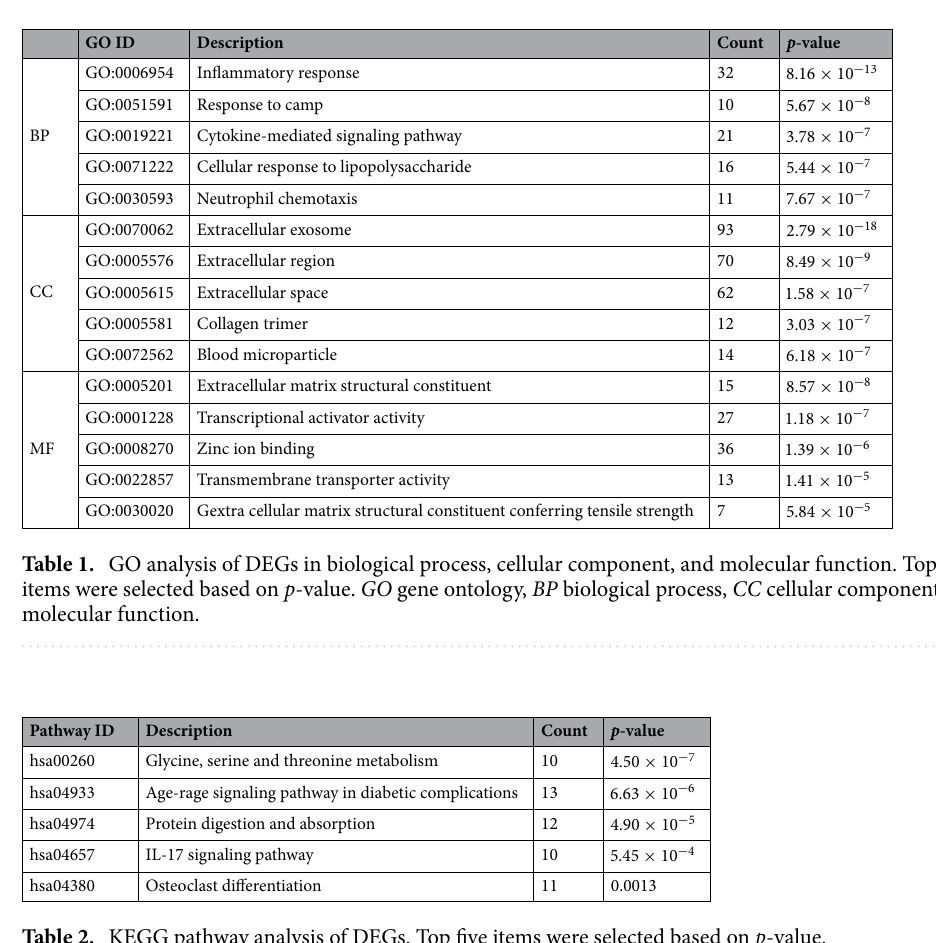
Table 2. KEGG pathway analysis of DEGs. Top five items were selected based on p -value.